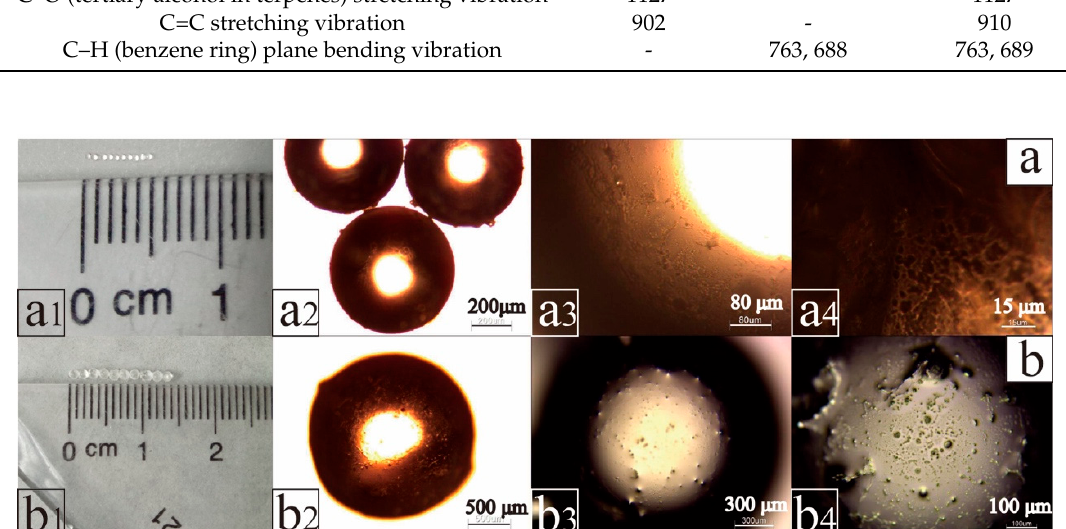
Figure 2. Surface topography of P(St-BMA) microspheres ( a ) and TTO microspheres ( b ).